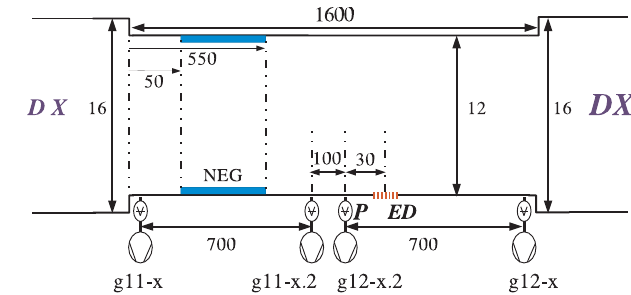
FIG. 5. (Color) Geometry of the common beam pipe IR12, made of baked stainless steel. The electron detector location (marked with ED ) is only 0.3 m away from the pressure gauge and vacuum ion pump, whose location is marked with P . Distances are given in cm and are not to